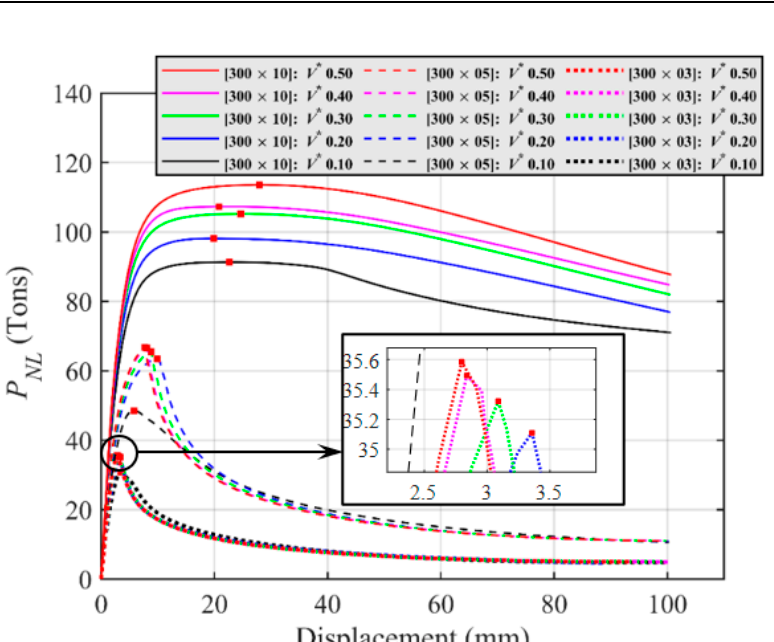
Figure 11. Load-displacement responses of SHS columns with optimal-topology stiffeners.